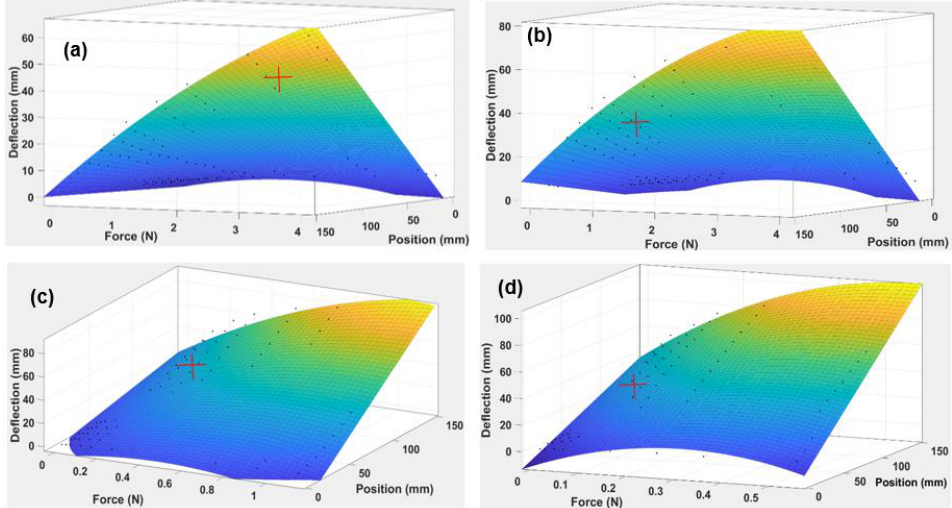
Figure 11. Three-dimensional gradient graph of ABS beam the showing relationship between applied Force (N), Position (mm), and Deflection (mm) for four beam thicknesses: ( a ) 3 mm, ( b ) 2 mm, ( c ) 1 mm, ( d ) 0.5 mm .